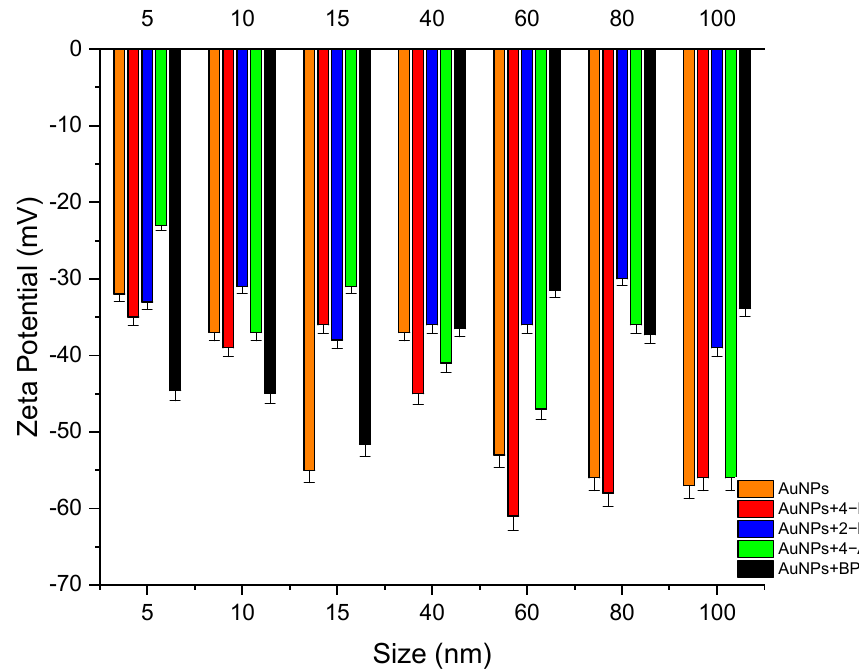
Figure 5. Zeta potential of (orange) bare AuNPs, and in the presence of a label: (red) 4-MBA, (blue) 2-NT, (green) 4-AATP, and (black) BPT for different NP sizes. Error bars: standard deviation.